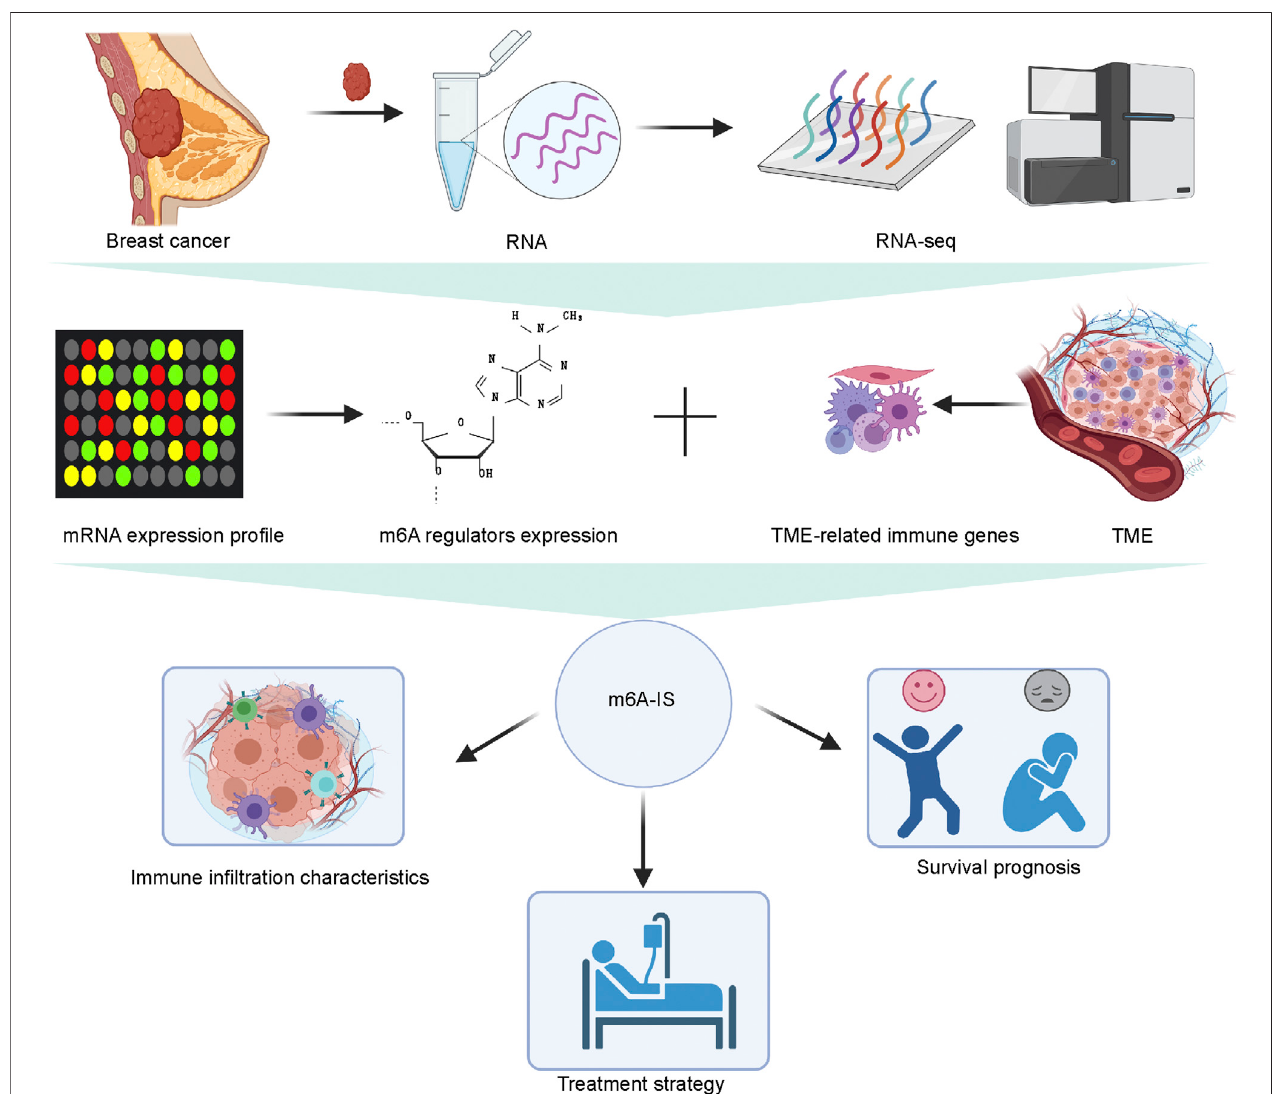
FIGURE 8 | Illustration for this